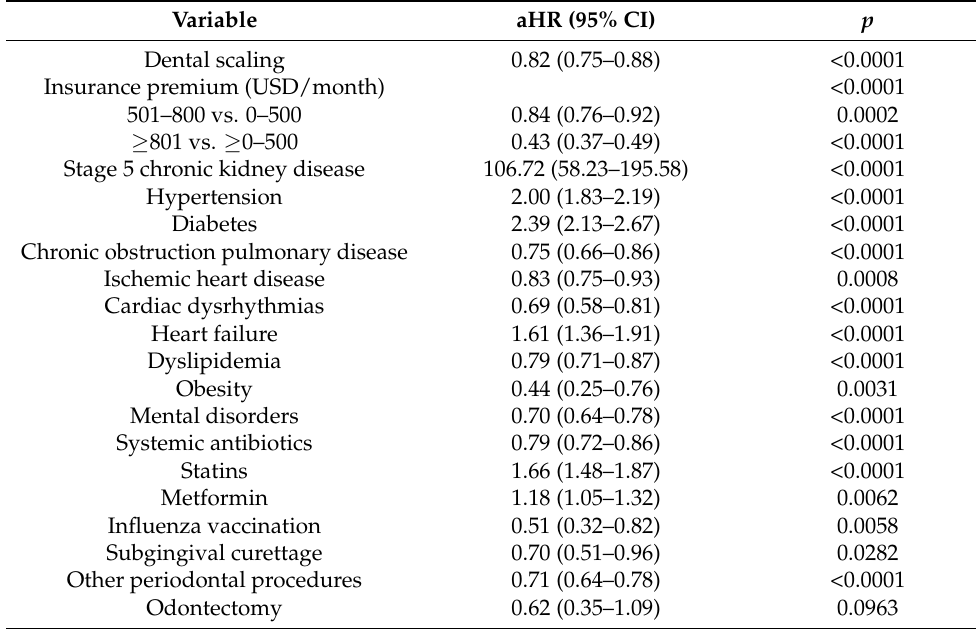
Table 3. Independent factors associated with ESRD.